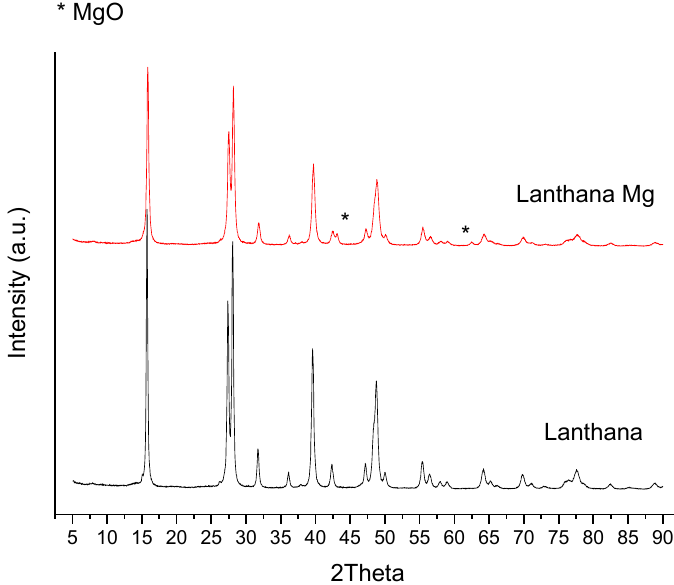
Figure 10. XRD patterns of calcined lanthana and lanthana Mg.